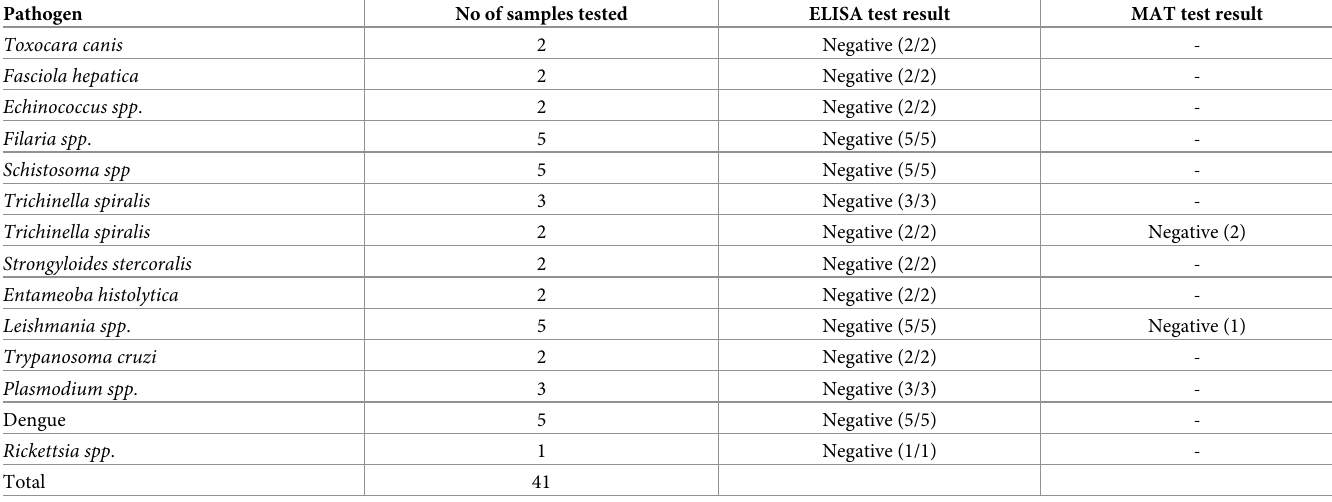
Table 1. Sera from clinically ill patients with a confirmed parasitic, bacterial or viral infection tested by the Serion IgM ELISA (REF EST125M) for anti-leptospiral antibodies and partially confirmed by the Microscopic Agglutination Test (MAT). Pathogen